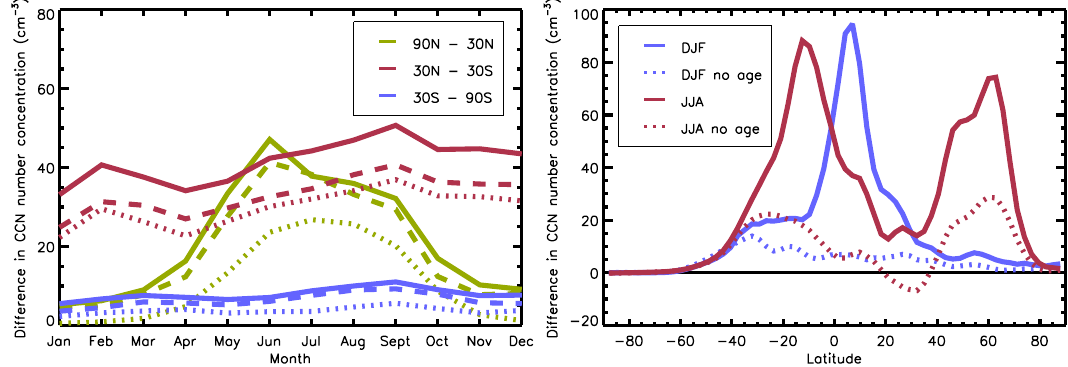
Fig. 2. Left: monthly mean absolute change in surface CCN number concentration (cm − 3 ) at 0.2% supersaturation, across three latitude bands, when monoterpene (expt. 2; dashed lines), isoprene (expt. 3; dotted lines) and both monoterpene and isoprene (expt. 4; solid lines) emissions are included in a simulation using the ACT mechanism. Right: seasonal mean absolute change in CCN number concentration (cm − 3 ) at 0.2% supersaturation during December–February (blue) and June–August (red) using the ACT mechanism; expt. 4 results (solid lines) include emissions of both monoterpenes and isoprene, expt. 8 results (dotted lines) are equivalent but condensable organics do not transfer hydrophobic particles to the hydrophilic